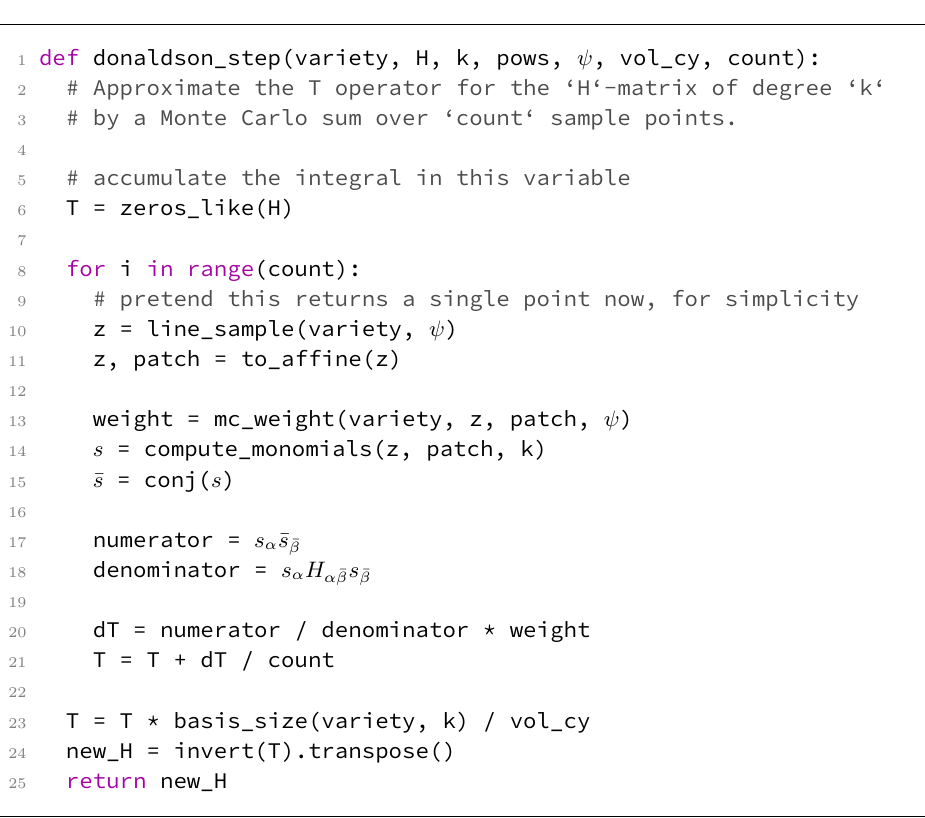
Algorithm 1 . Simplified algorithm for computing a single iteration of Donaldson’s